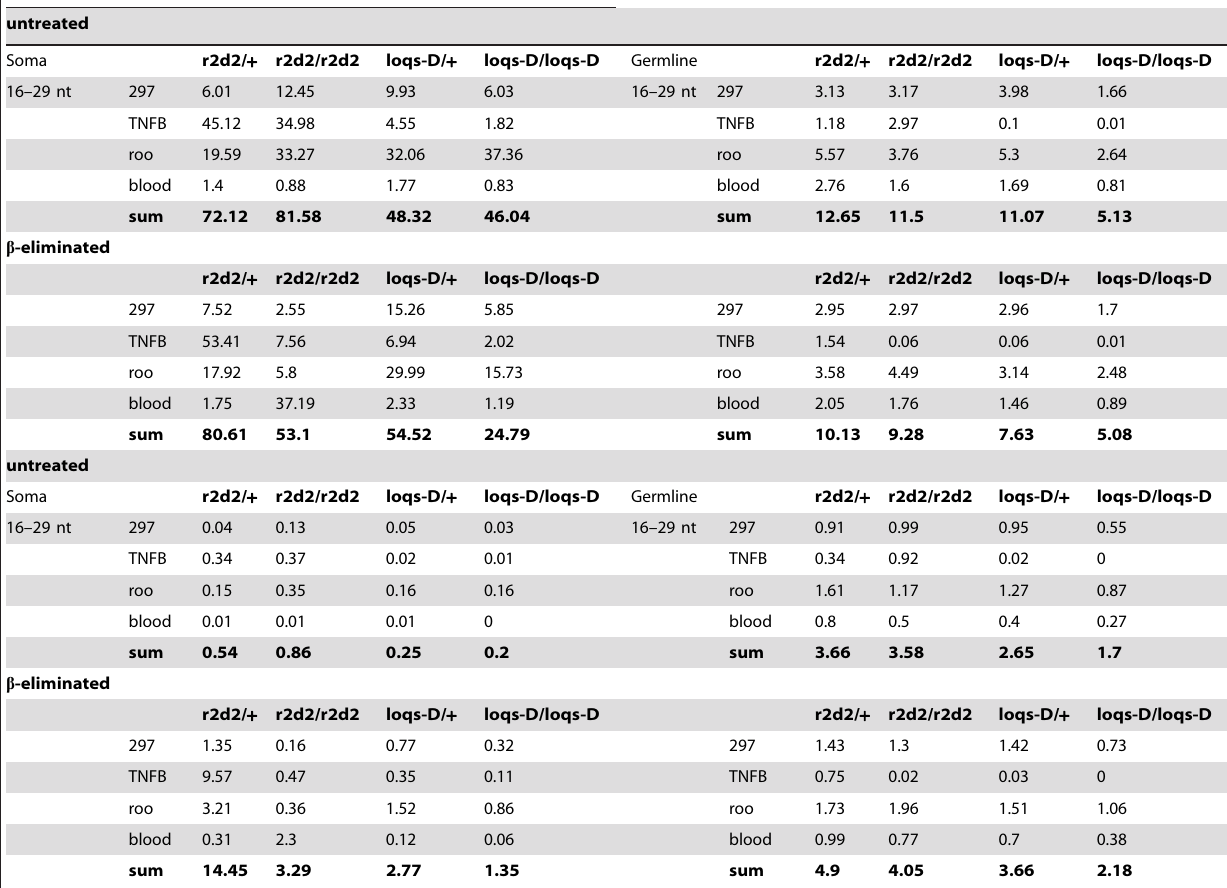
Table 2 . The counts of 297, TNFB, roo and blood matching small RNAs.